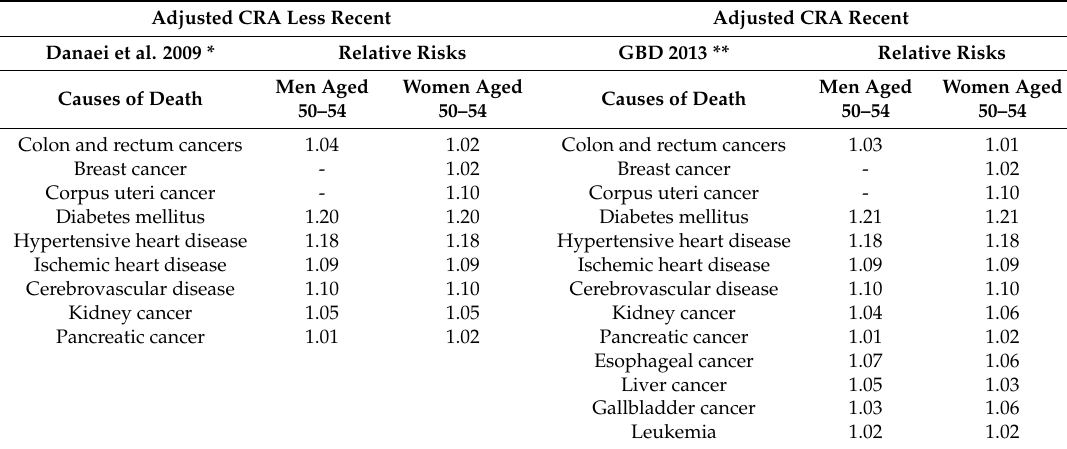
Table 1. Causes of death used in the two adjusted CRA approaches and the associated RRs ranging from ages 50 to